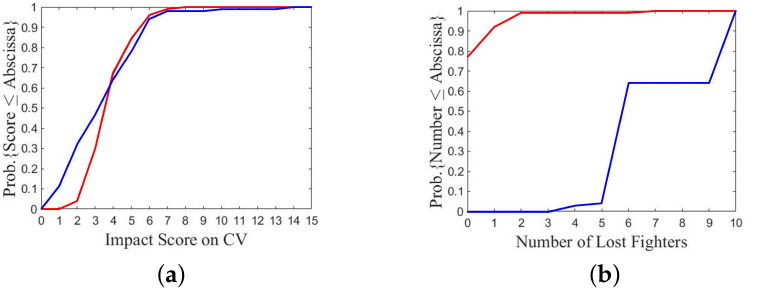
Figure 15. (A2/B2) Cumulative distribution of ( a ) impact score on CV and ( b ) lost fighters, over 100 games with one P 2 SO run, ———: fleet A, ———: fleet B.